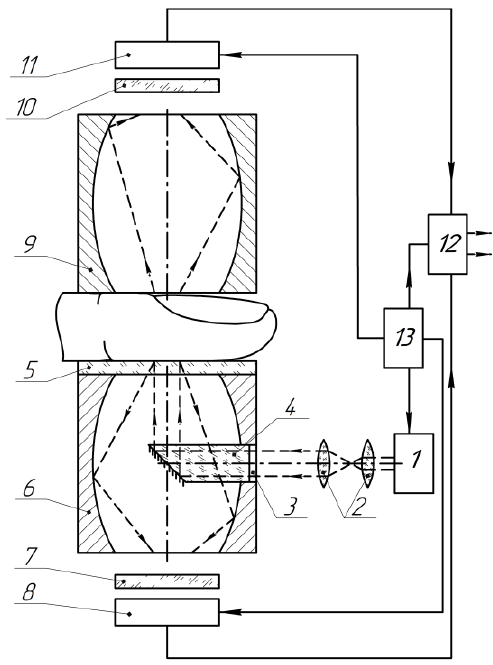
Fig. 2. The scheme of the optical glucometer with ellipsoidal reflectors: 1 – laser; 2 – telescoping system; 3 – inlet window; 4 – prism; 5 – slide glass; 6 – bottom ellipsoid; 7, 10 – edge filters; 8, 11 – photo diodes; 9 – top ellipsoid; 12 – processing system; 13 – power